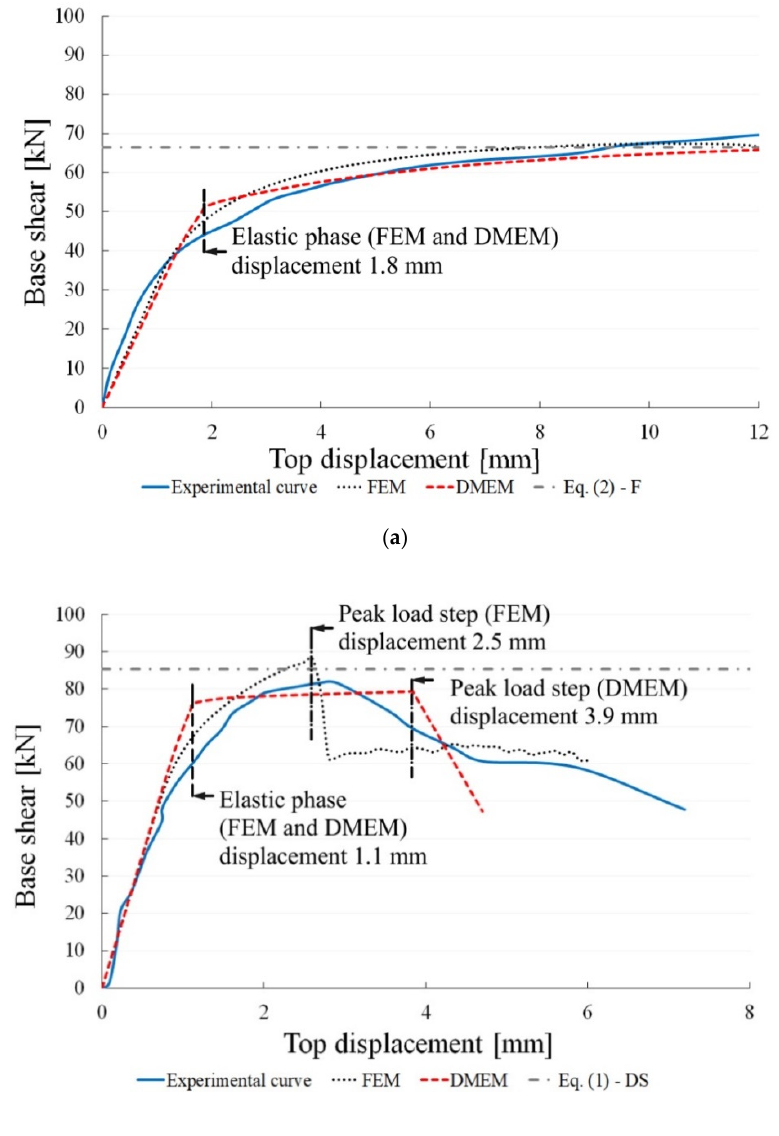
Figure 5. Experimental vs. numerical curves given by the FEM and DMEM for: ( a ) slender and ( b ) squat walls.